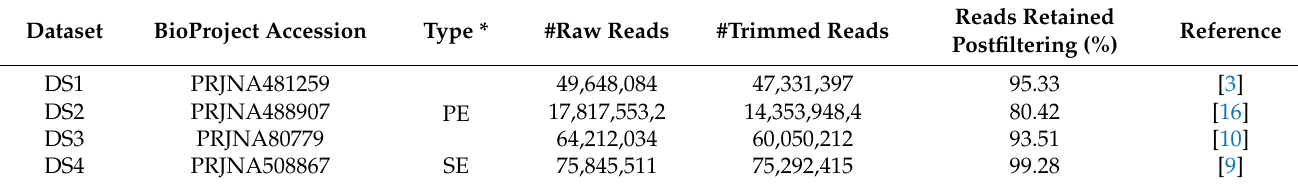
Table 1. Summary of the datasets and the number of trimmed reads retained